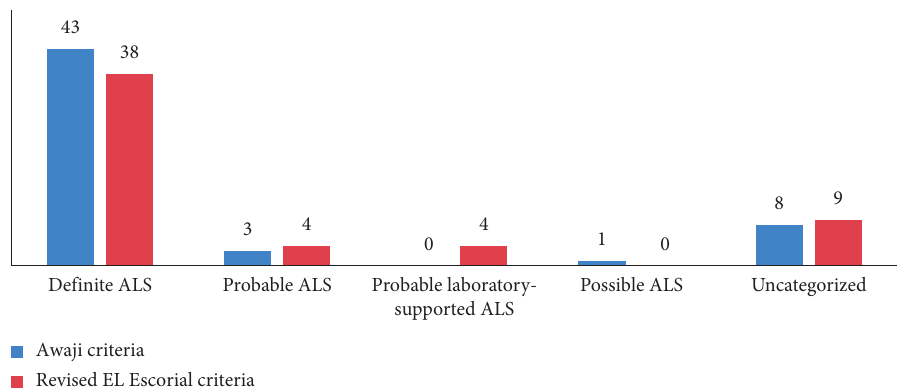
Figure 5: Diagnostic categories of ALS patients with a duration of evolution of the disease exceeding 24 months, according to the AC and